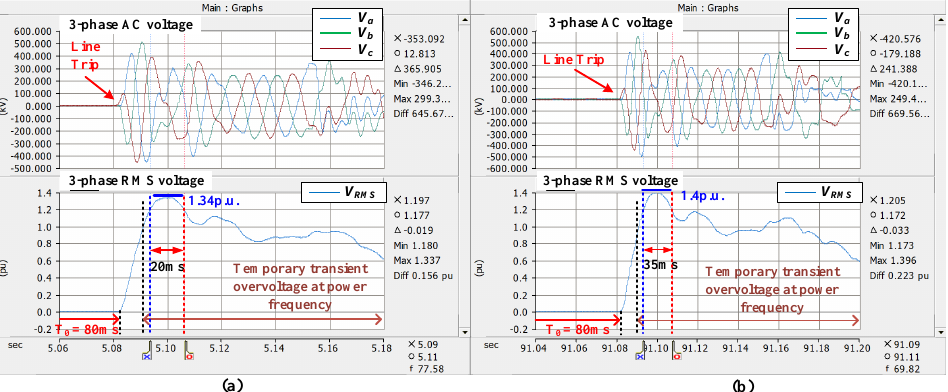
Figure 12. PSCAD/EMTDC simulation results according to interface transfer tap changer status. ( a ) Before interface transformer tap change and ( b ) after tap changer 1% increase.